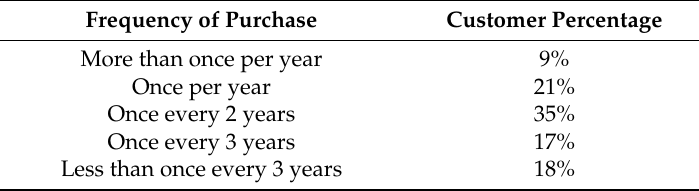
Table 2. Frequency of US smartphone owners purchasing a new iOS smartphone.